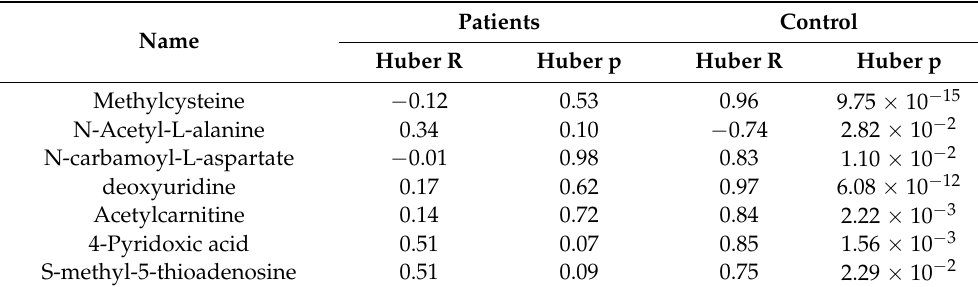
Table 2. Metabolites with plasma-CSF correlation lost in patients compared to control group. Huber R/p denotes the corresponding R- or p-value of the correlation coefficient for the model with Huber M-estimates.